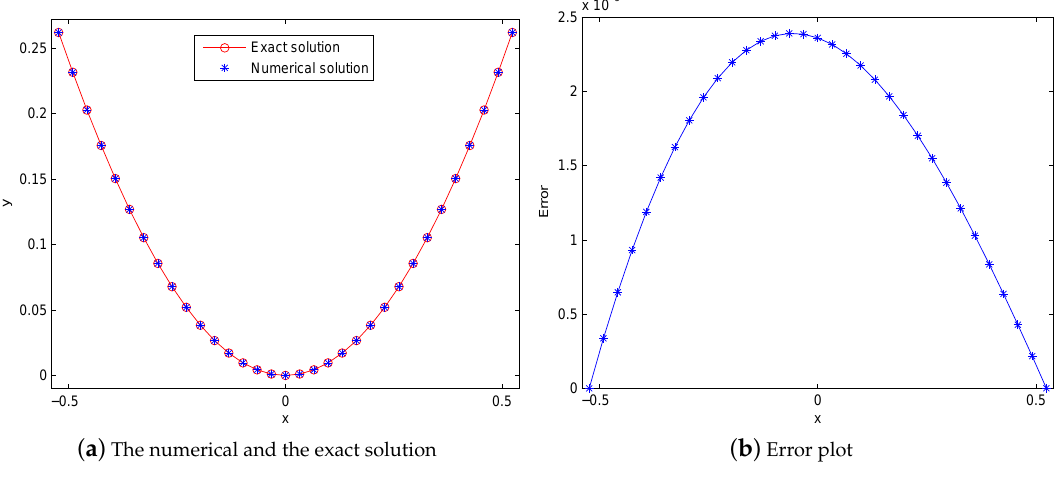
Figure 1. Numerical results in Example 2 ( n = 32).